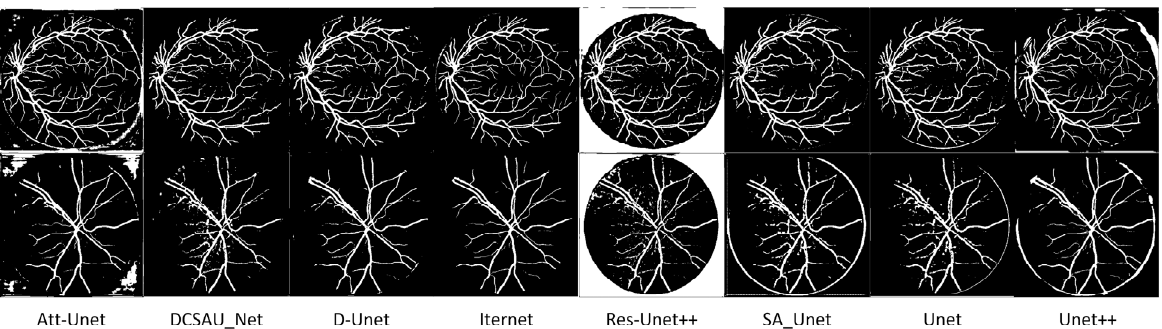
Figure 9. Predicted images from other models. The top row is the DRIVE dataset, and the bottom row is the CHASE_DB1